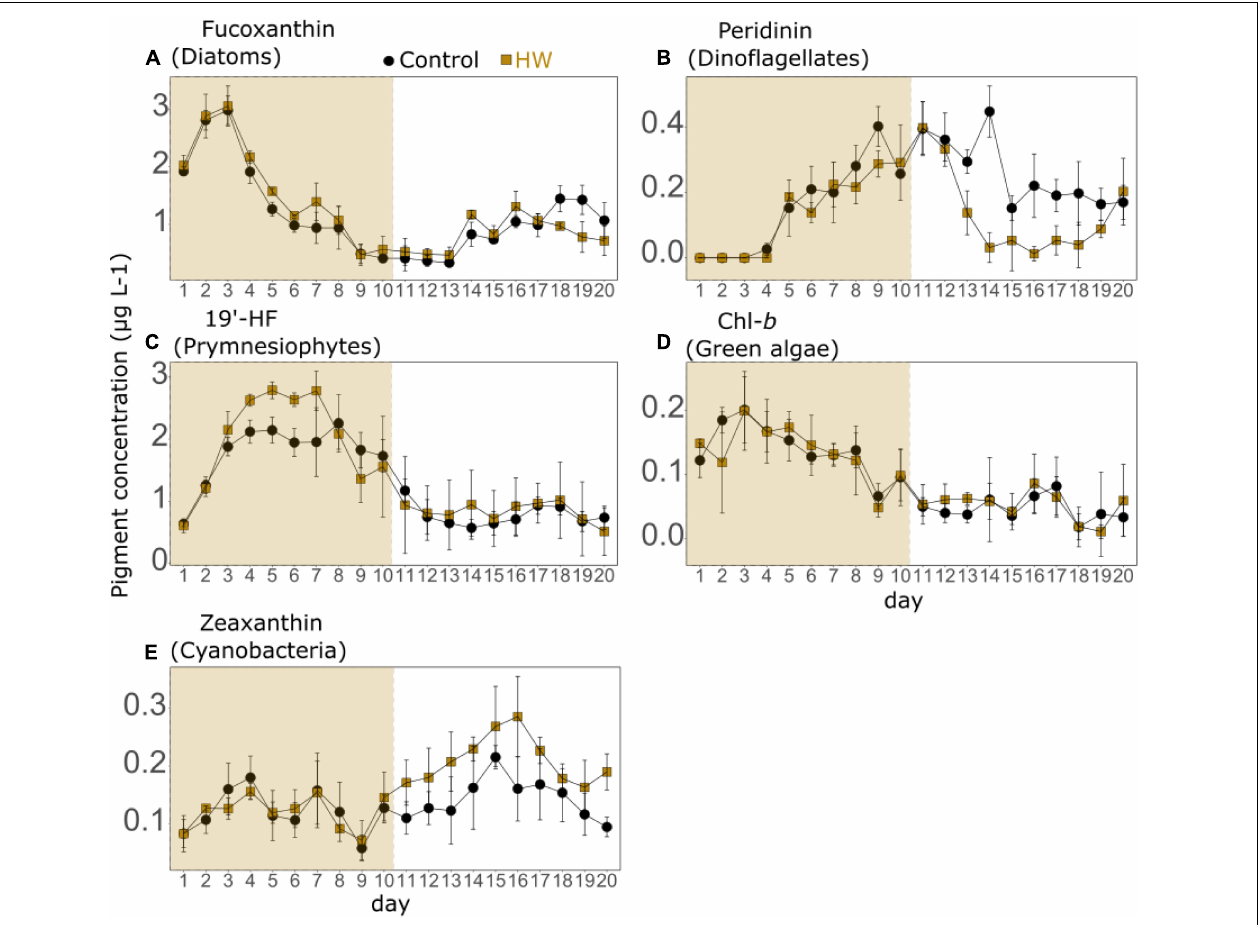
FIGURE 3 | Phytoplankton functional types (PFTs) assessed as daily mean concentrations of fucoxanthin (A) , peridinin (B) , 19 (cid:48) -hexanoyloxyfucoxanthin (19 (cid:48) -HF, C ), chlorophyll- b (Chl- b , D ), and zeaxanthin (E) in the control (black) and HW (gold) treatments. The gold shaded area represents the HW period during which the +3 ◦ C was applied in the HW mesocosms. Error bars represent the standard deviation. Note that the scales of the y-axes are